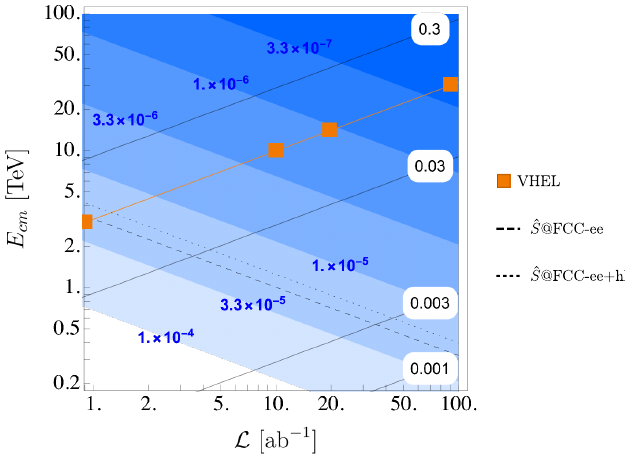
Figure 3 . Iso-contours (blue shades) of the 1 σ sensitivity to C W , in terms of the b S parameter in eq. (2.3), in the luminosity-energy plane. The FCC reach is also indicated, as well as (solid black) the iso-contours of the relative statistical uncertainty of the cross-section